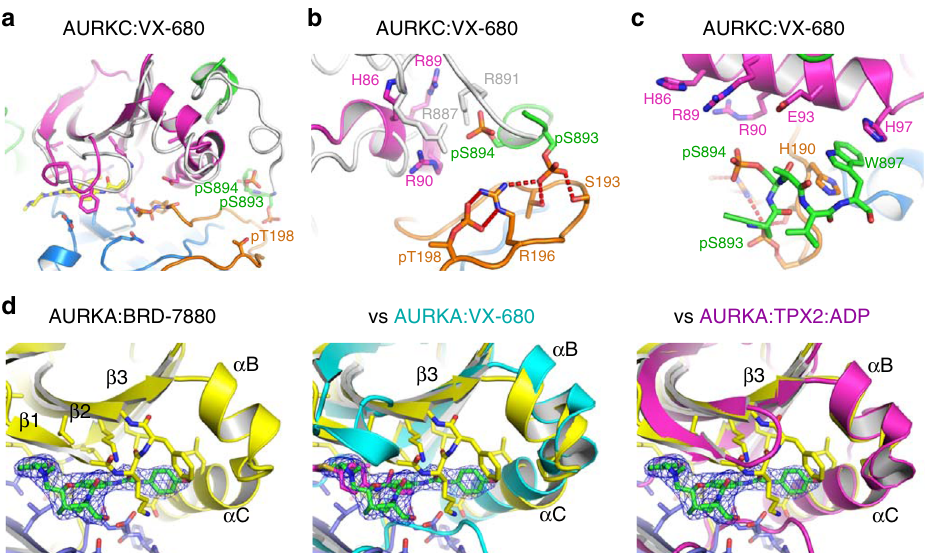
Fig. 4 VX-680 binding partially disrupts AURKC:INCENP and affects the substrate binding groove. a Crystal structure of AURKC:INCENP:VX-680. AURKC is in magenta for the N-lobe, blue for the C-lobe and orange for the activation loop. INCENP is shown in green, VX-680 in yellow. The parts of the AURKC: INCENP:BRD-7880 structure that differ in position from the structure with VX-680 are shown in grey, illustrating the parts of AURKC:INCENP disrupted by VX-680 binding. b VX-680 binding to AURKC disrupts INCENP binding to the activation loop, disrupting the substrate binding surface. INCENP is shown in green and the part of INCENP not observed in the crystal structure is shown in grey, based on the structure of AURKC:INCENP:BRD-7880. c Binding of INCENP Trp897 to the C-terminal part of AURKC α C is maintained in the presence of VX-680. d A crystal structure of AURKA with BRD-7880 shows that the binding mode of BRD-7880 is conserved. Comparison of this structure with previously published structures of AURKA with VX-680 shows that, as with AURKC, BRD-7880 allows an Aurora kinase conformation resembling the active form exempli fi ed by AURKA:TPX2:ADP, while VX-680 causes a rotation of the N-lobe that disrupts the positions of α B and α C. A 2 F o – F c electron density map is shown in blue around BRD-7880, contoured at 1.0 σ (0.14eÅ − 3